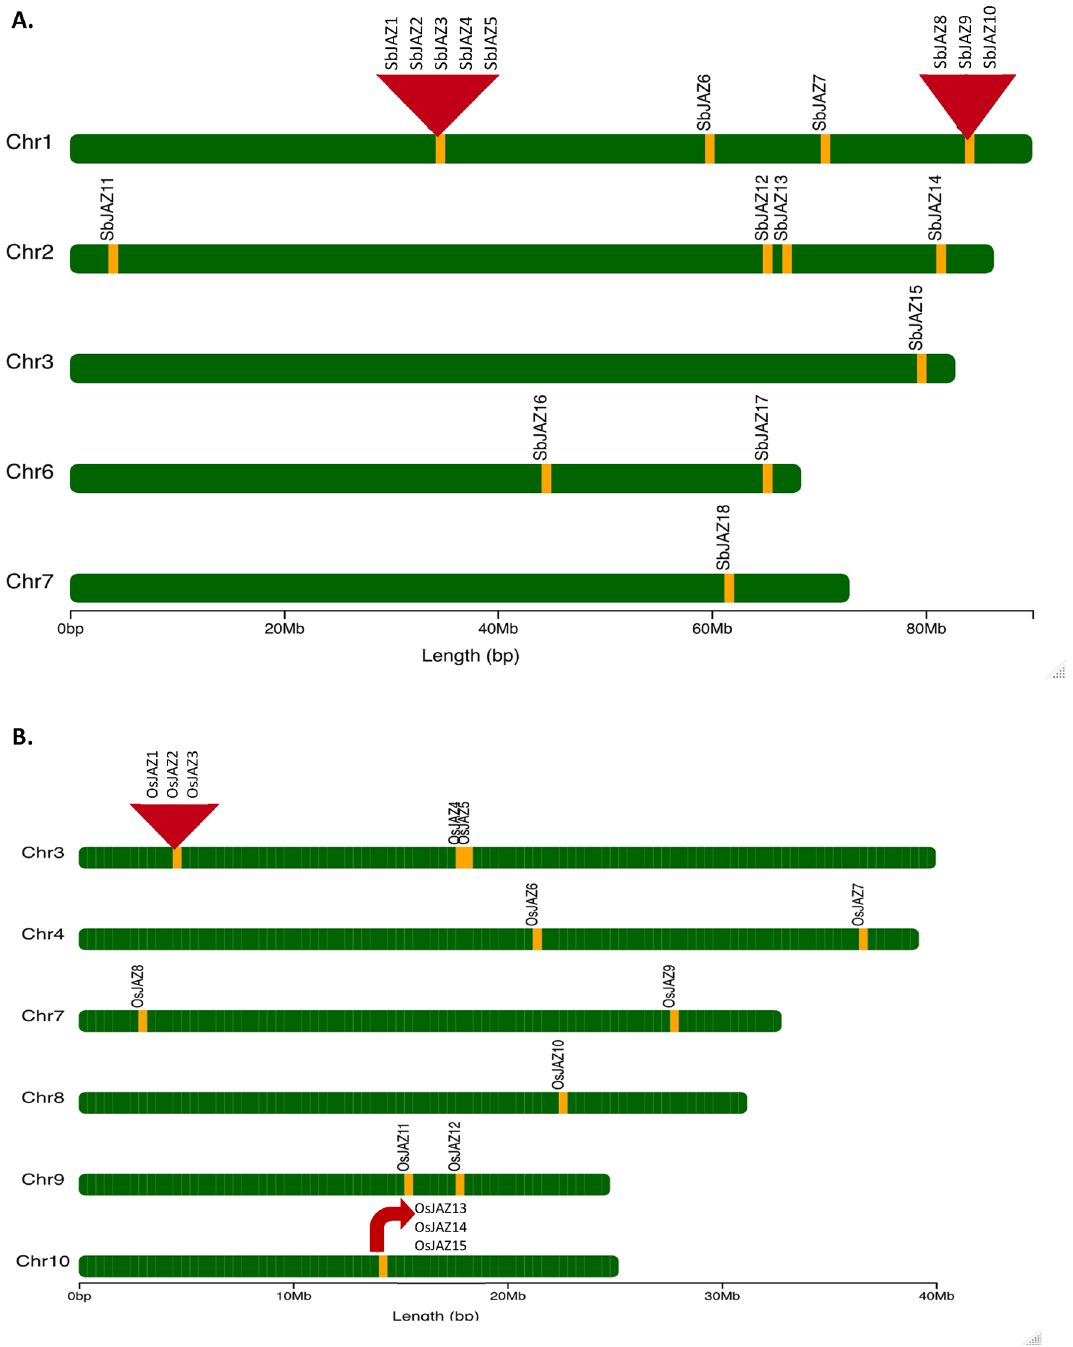
Figure 4. Genome mapping of the 18 SbJAZ genes on S. bicolor chromosomes ( A ) and 15 OsJAZ genes on O. sativa chromosomes ( B ). Gene locations and chromosome size can be measured using the scale on the bottom of the